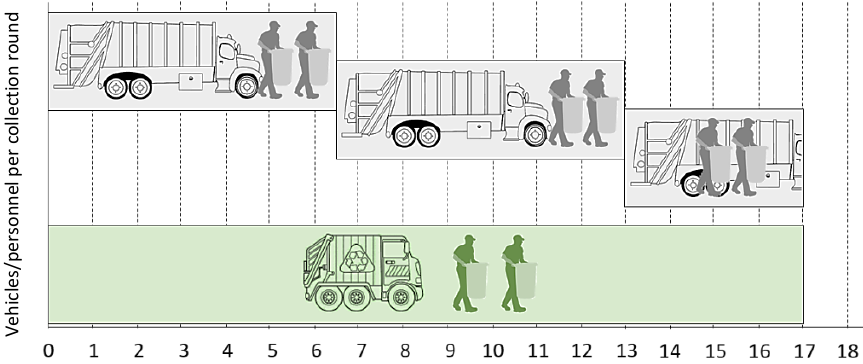
Figure 11. Number of rounds of collection of uncompacted and compacted waste.